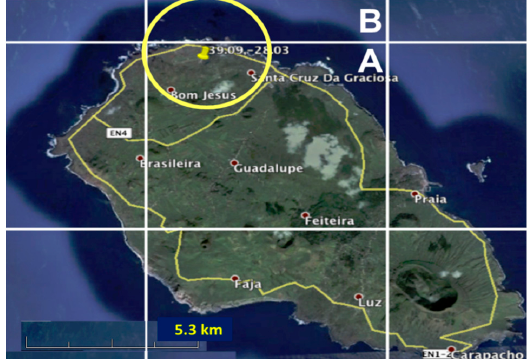
Figure 2. An image from Google Earth shows the approximate position of 0.05° grid boxes. The AMF site is located at the northern end of box A . This box represents mostly land and also a small fraction of ocean. The adjacent box B (in the northern direction) characterizes ocean only. A circle (yellow) with radius about 2 km defines an approximate area that is representative of the areal-averaged surface albedo retrieved from MFRSR data. Table 1. Spectrally-resolved values of the surface albedo for vegetation, soil, ocean at five MFRSR wavelengths. It is assumed that that these values are